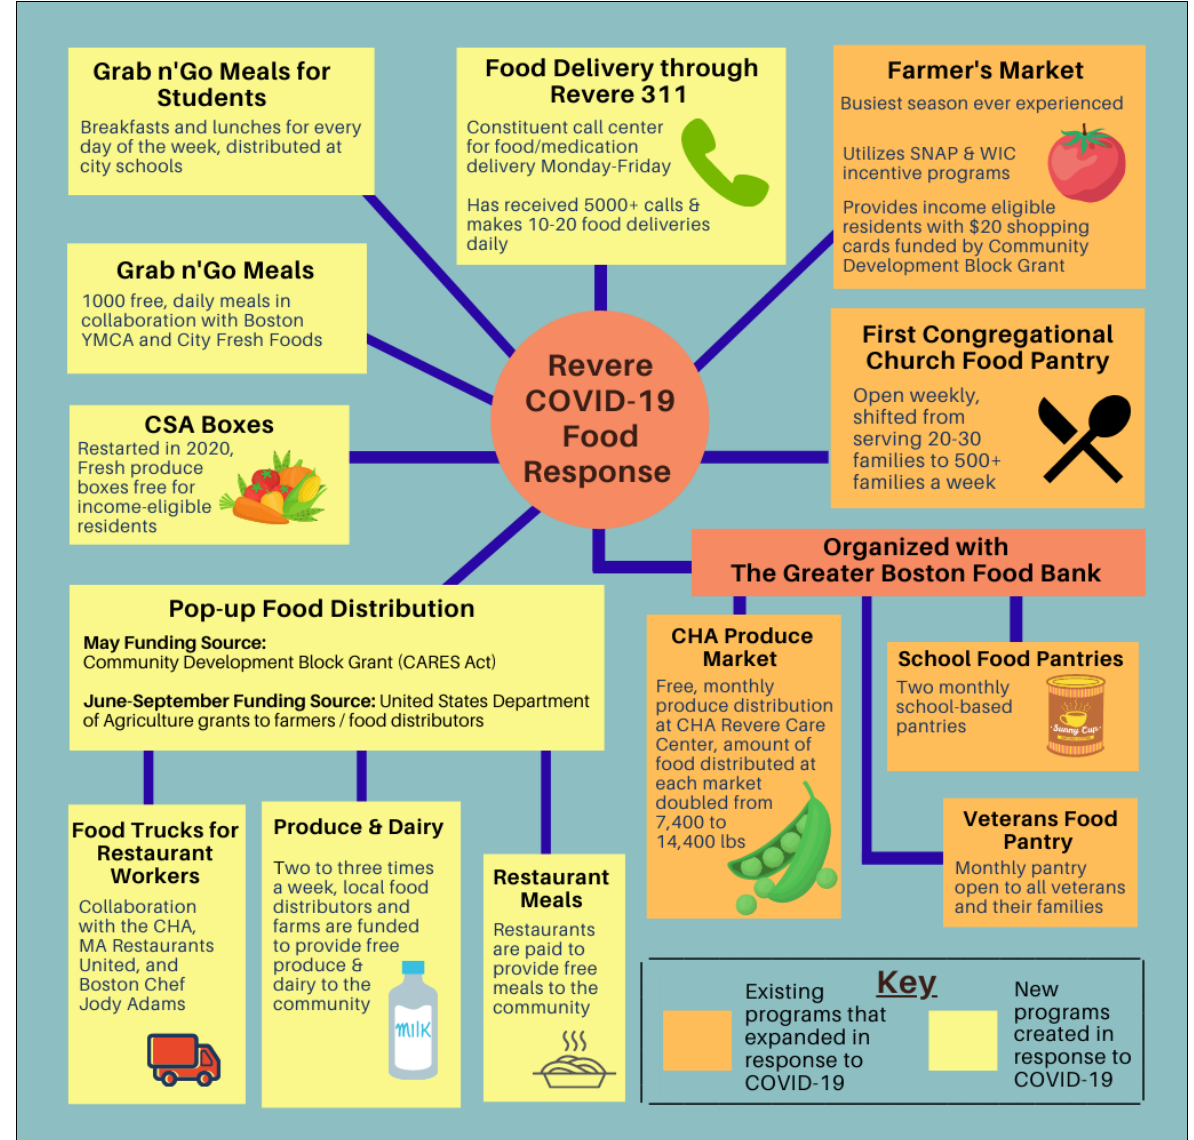
Figure 1. The Community Food Response to COVID-19 in Revere,